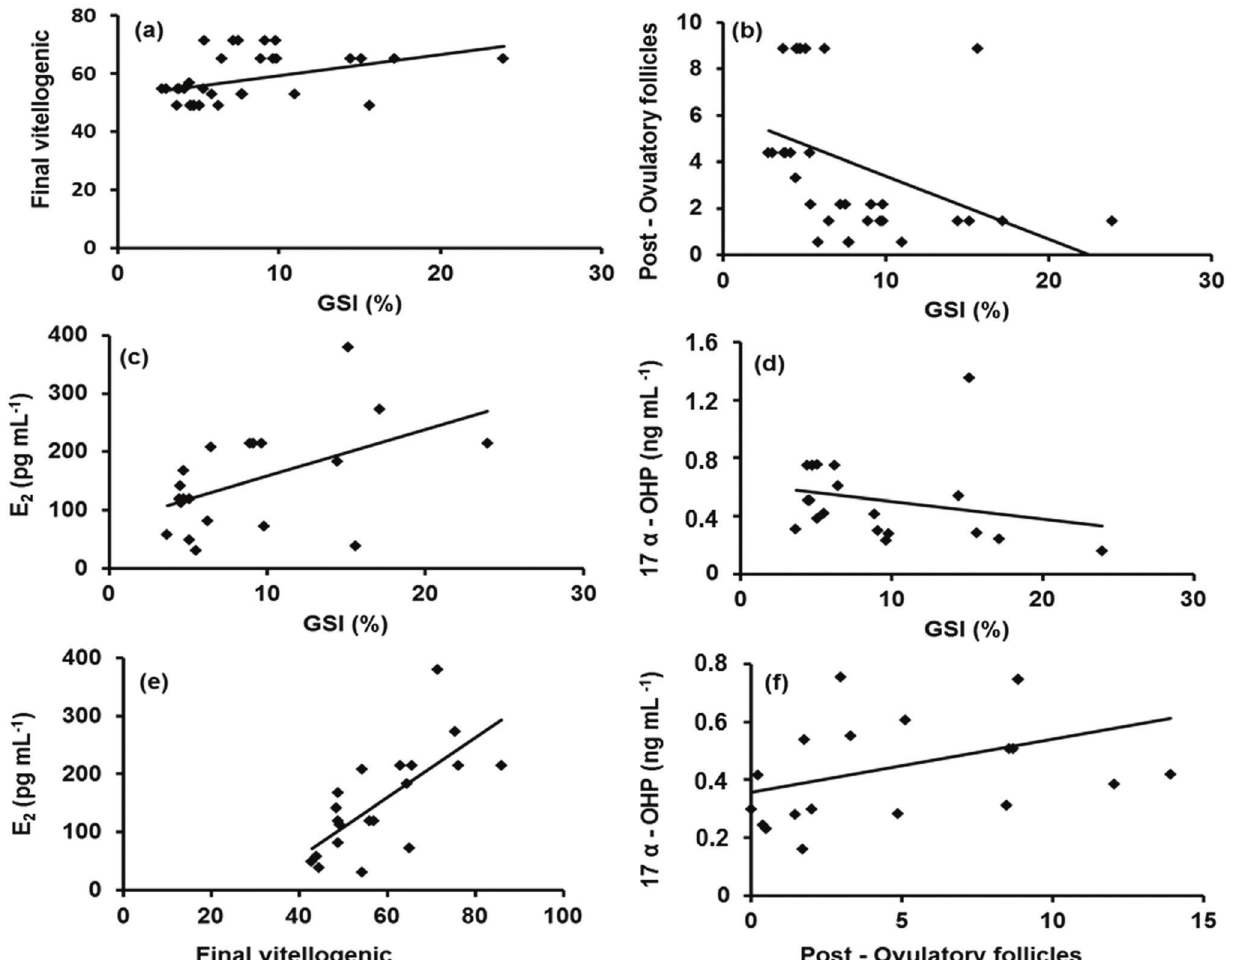
Fig. 5. (a) Pearson correlation between the volume density of final vitellogenic oocytes and the gonadosomatic index (GSI) (%) during the reproductive cycle of Metynnis maculatus females (n = 36). (b) Pearson correlation between the volume den- sity of post-ovulatory follicles and the GSI (%) (n = 36). (c) Pearson correlation between the E plasma levels and the GSI 2 (%) (n = 20). (d) Pearson correlation between the 17 α -OHP plasma levels and the GSI (%) (n = 20). (e) Pearson correlation between the E plasma levels and the volume density of final vitellogenic oocytes (n = 20). (f) Pearson correlation between 2 the 17 α -OHP plasma levels and the volume density of the post-ovulatory follicles (n = 20). The continuous line indicates that the difference is statistically significant (Pearson’s test, P < Correlations between variables . We observed a positive correlation between the GSI and the FV oocytes (Pearson correlation: r = 0.52, P = 0.001, n = 36, Fig. 5a) and a negative correlation between the GSI and the POF (Pearson correlation: r = -0.50, P = 0.002, n = 36, Fig. 5b). The plasma E levels were positively correlated with GSI (Pearson 2 correlation: r = 0.52, P = 0.01, n = 20, Fig. 5c) and with